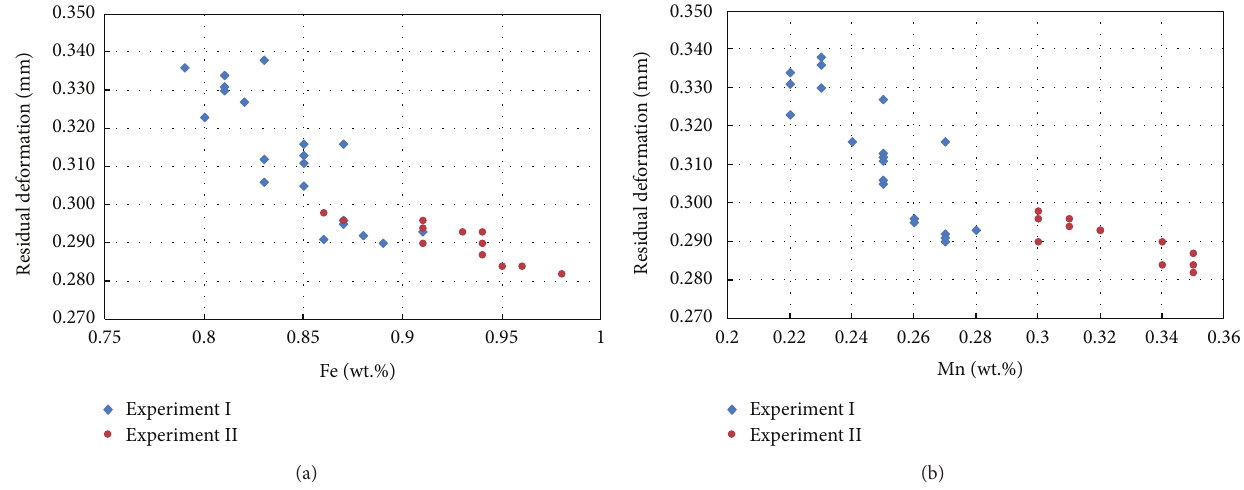
Figure 2: Dependence courses of residual deformation on change of Fe and Mn content.